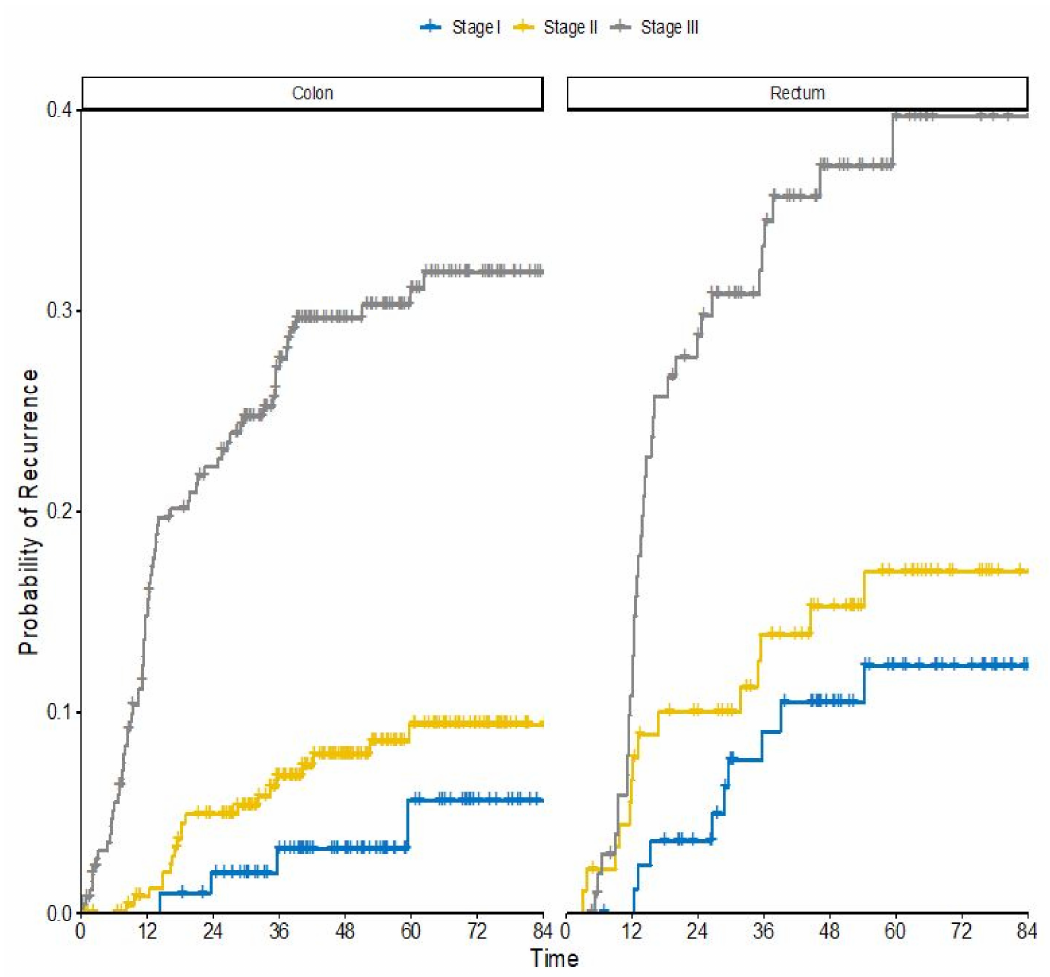
Figure 1. Colorectal cancer recurrence risks by tumor location and stage. Kaplan Meier event plot split by diagnosis and stage. Outcome is recurrence after radical surgery in a Swedish population-based cohort diagnosed between 2010–2017 with minimum 2 years